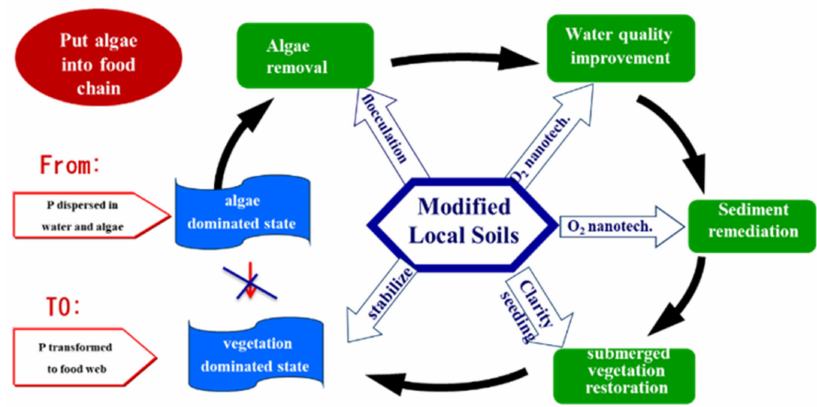
Figure 1. Multi-disciplinary principle of Modified Local Soil (MLS)